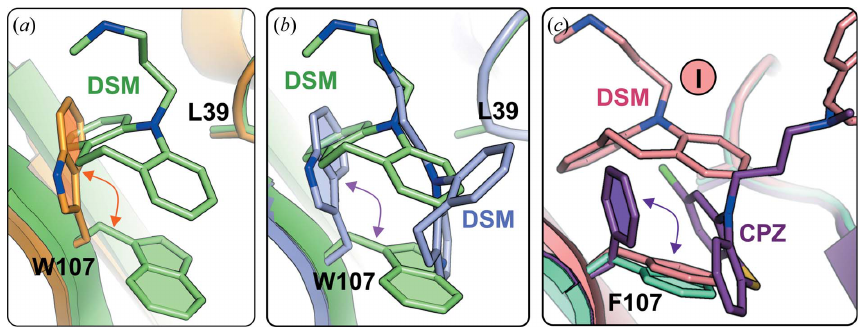
Figure 4 ( a ) Conformational changes of Trp107 associated with DSM binding in the (cid:2) -barrel of the FAW– DSM#1 complex (green); the conformation of Trp107 in the unliganded protein is shown in orange. ( b ) Differences in the conformation of Trp107 and the position of DSM between FAW–DSM#1 (light green) and FAW–DSM#3 (light violet). ( c ) Conformational changes of Phe107 in FAF related to the ligand type accommodated in the (cid:2) -barrel: Phe107 in unliganded FAF (light green), the conformation of Phe107 and the position of the ligand in the FAF–DSM complex (salmon) and the conformation of Phe107 and chlorpromazine in the FAF–CPZ complex (PDB entry 5nuk, violet).